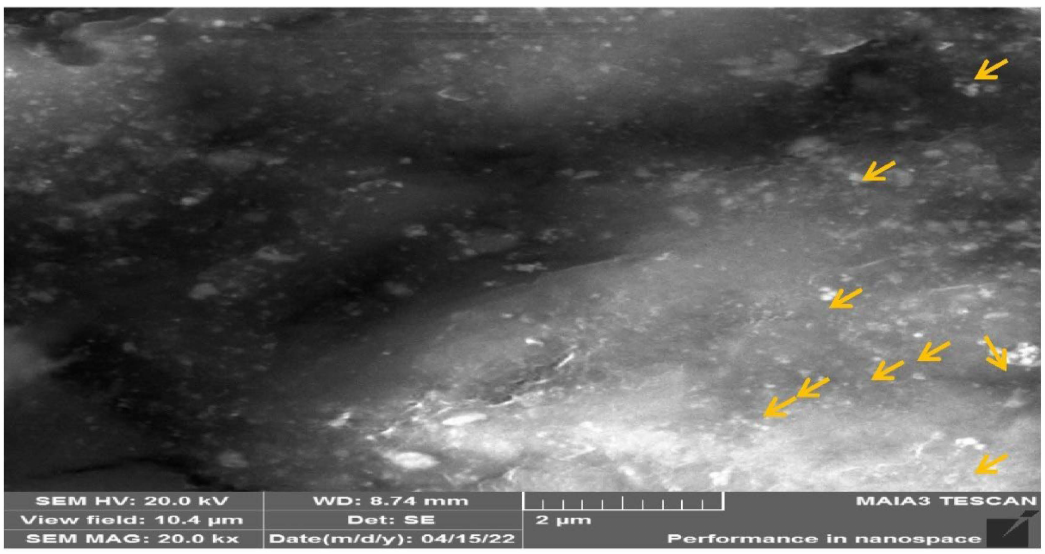
Figure 7. TESCAN shows the even shape and spherical nature of the developed particle (yellow arrows indicate spherical shaped